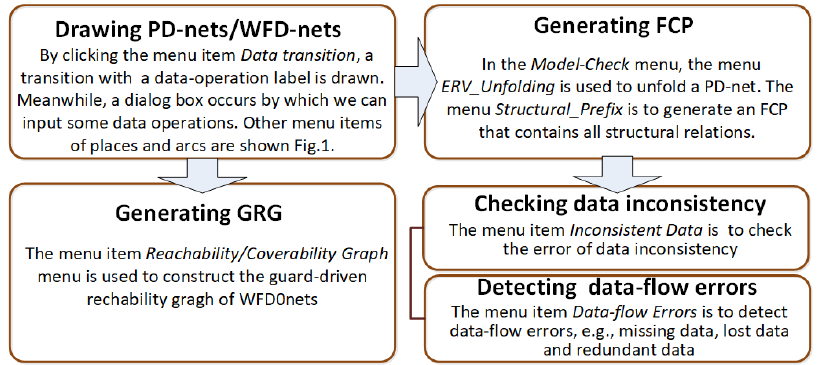
Figure 4. DICER 2.0 [45]. ( a ) Software interface; ( b ) the drawing menu and the model-checking menu.